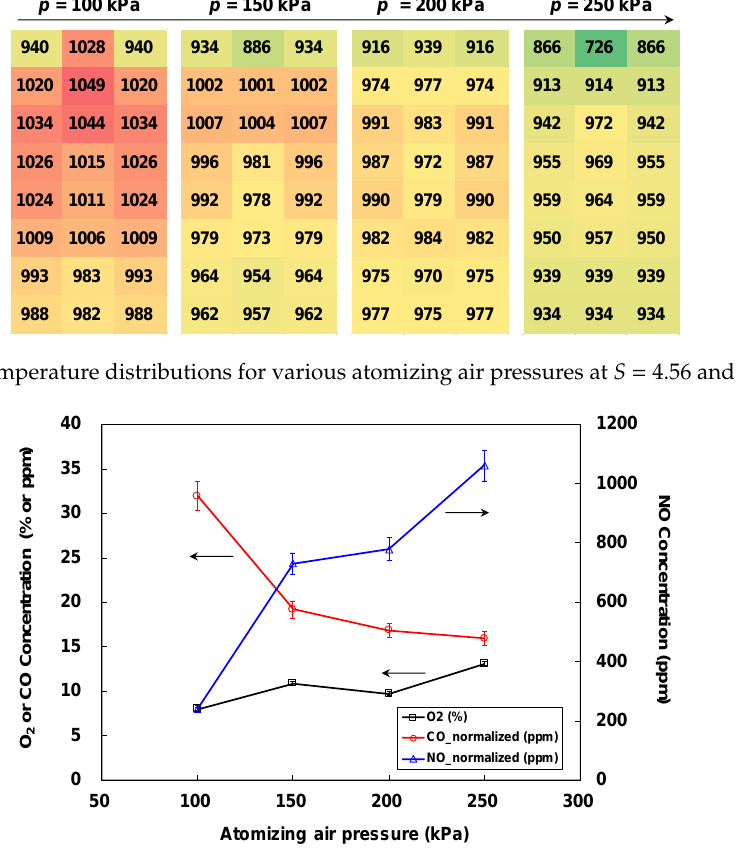
Figure 7. O 2 concentration (%), normalized CO and NO concentrations (ppm) for various atomizing air pressures at S = 4.56 and ϕ = 0.8.